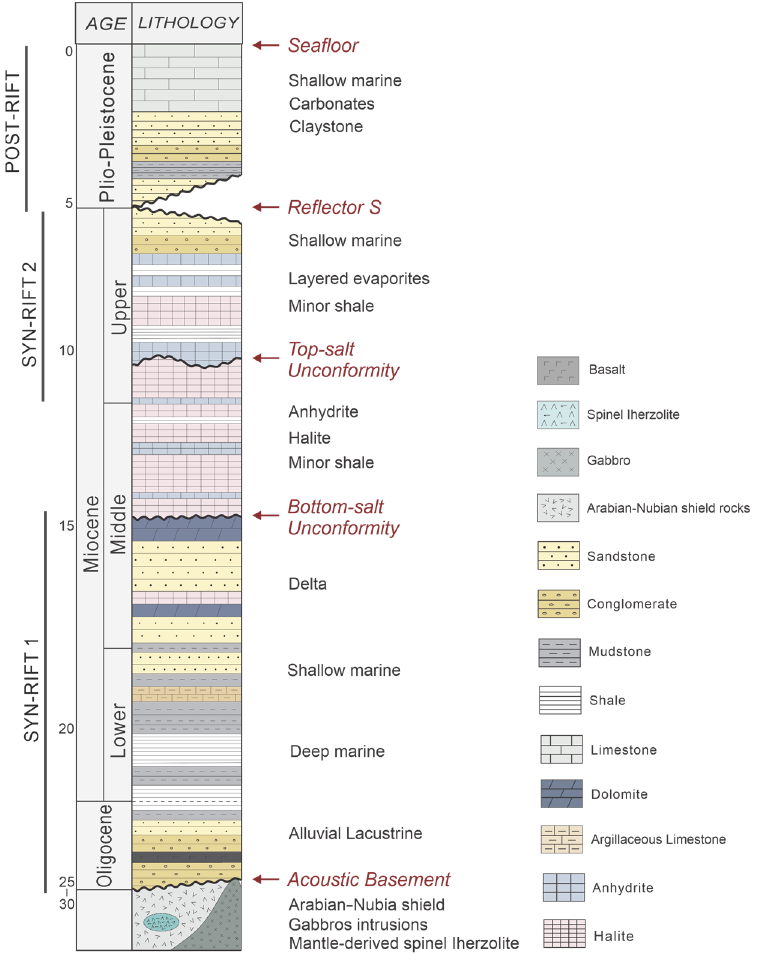
Figure 2. Stratigraphy of the Red Sea. Basement composition and stratigraphy refer to previous ge- ological studies and DSDP drill results